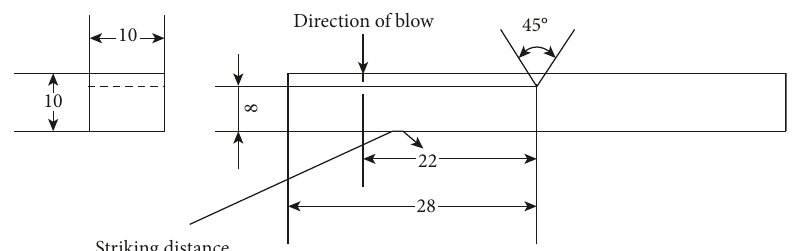
Figure 3: Diagram of specimen for impact strength.